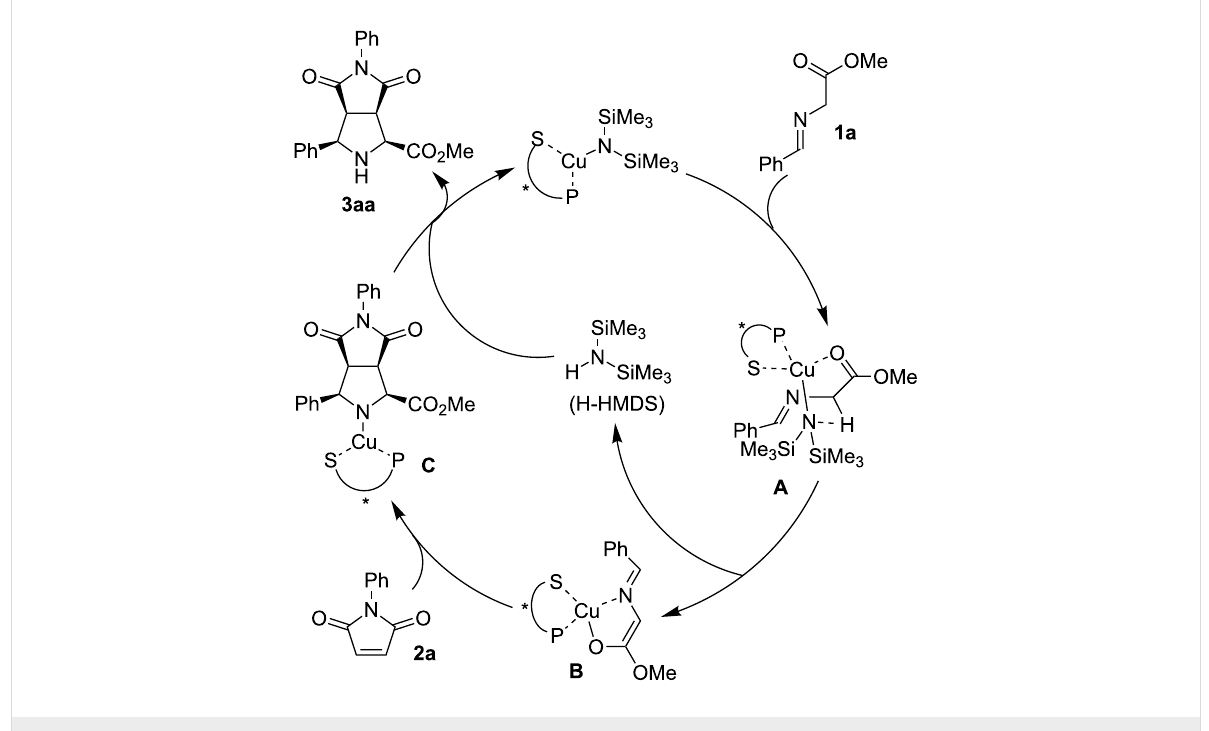
Figure 1: Proposed catalytic cycle.